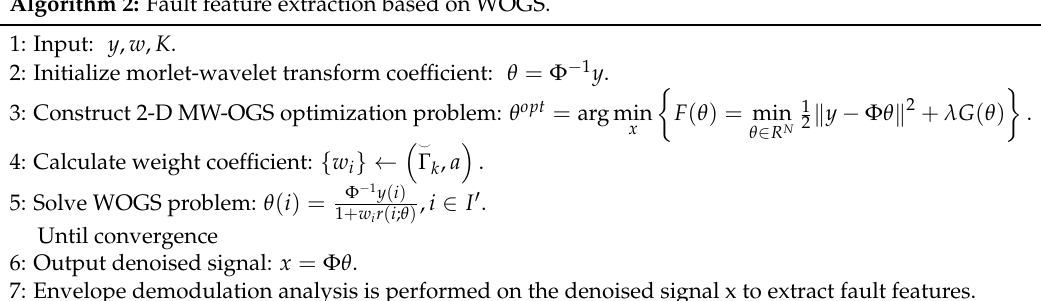
Algorithm 2: Fault feature extraction based on WOGS.